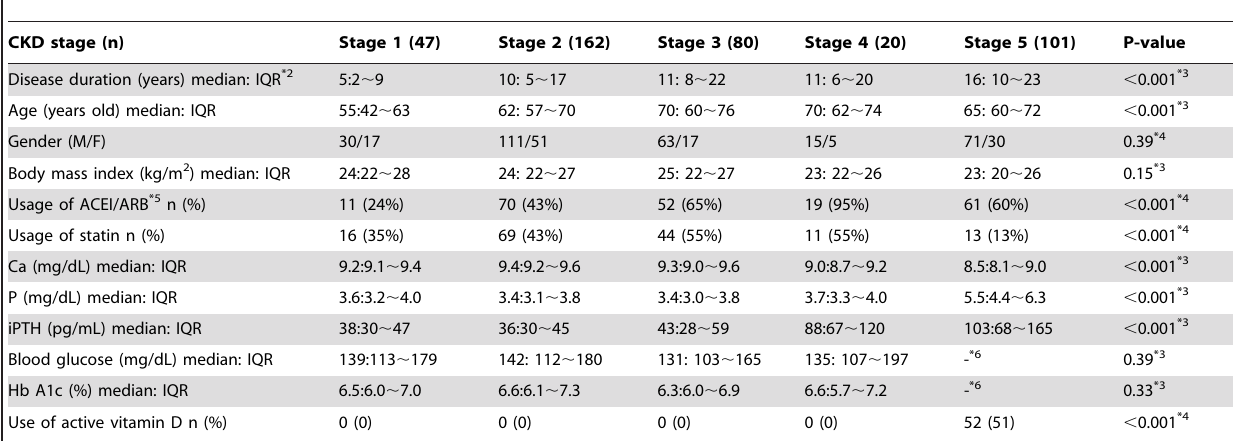
Table 1. Patients’ characteristics of the study population and association with eGFR stage *1 .